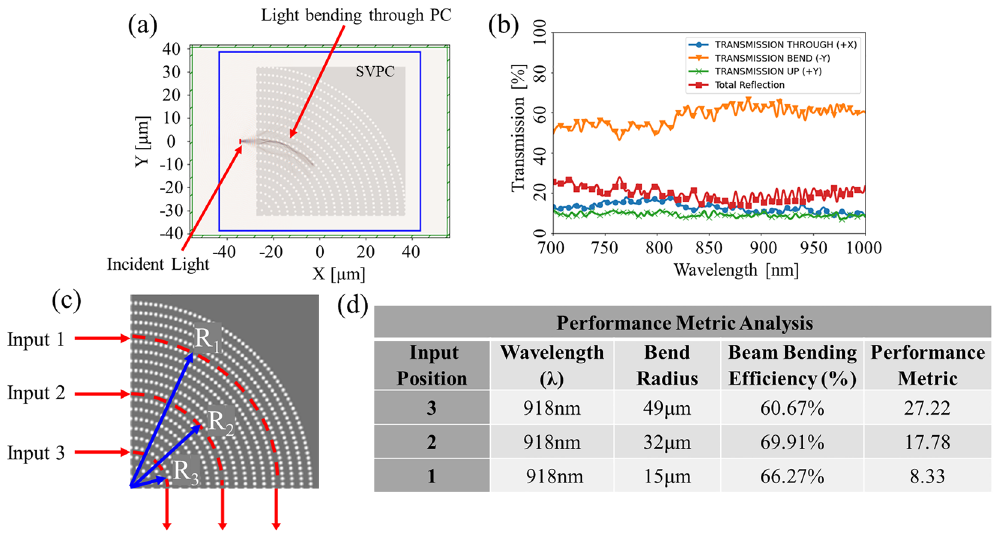
Figure 3. 2D simulation results from FDTD simulations in MEEP for 90-deg bend. ( a ) Propagation of light through SVPC for 90-degree bends. ( b ) Transmission properties for SVPC in NIR spectrum. ( c ) Input positions for PM analysis. ( d ) Results of PM analysis and comparison with bending efficiency and